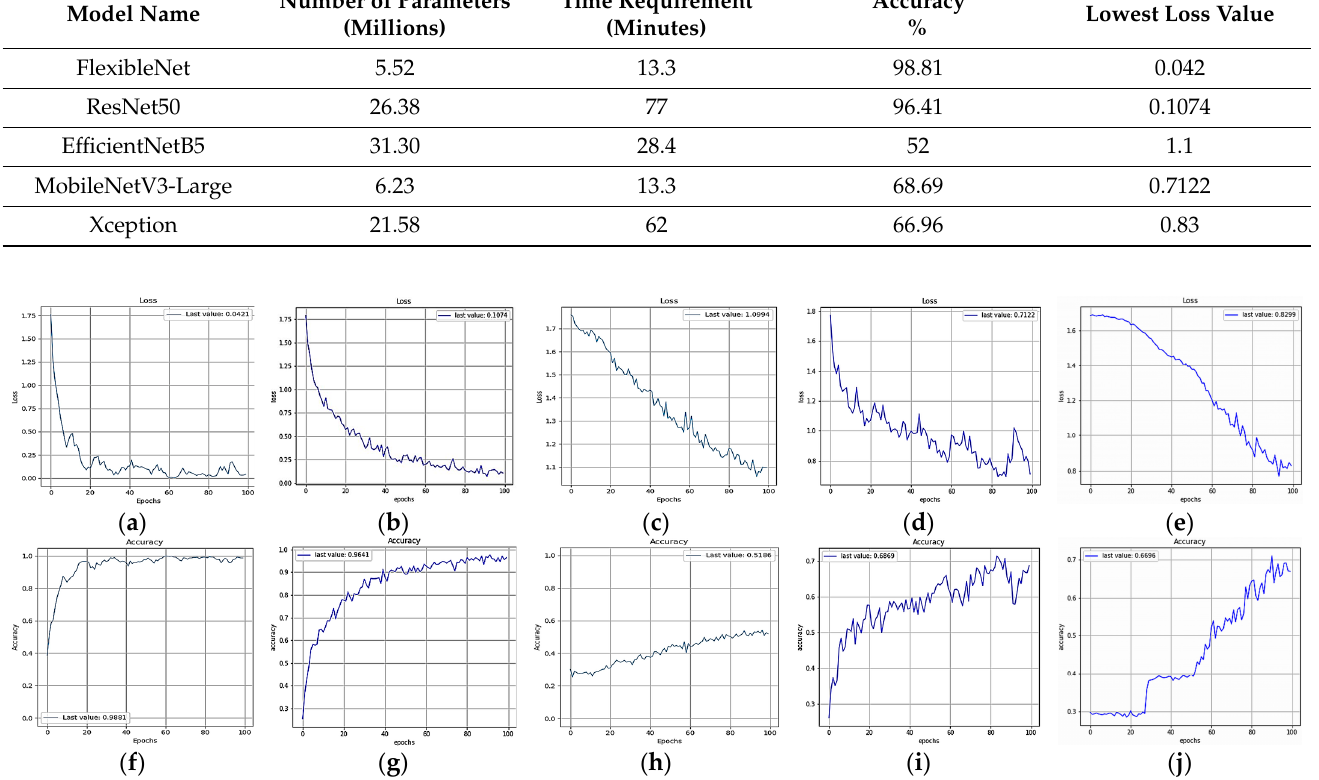
Figure 10. Loss and accuracy of sub-images of size 32 × 32 processed by ( a , f ) FlexibleNet, ( b , g ) ResNet50, ( c , h ) EfficientNetB5, ( d , i ) MobileNetV3-Large, and ( e , j ) Table 4. Summary of the outcomes of the experiments using an image resolution of 32 × 32.